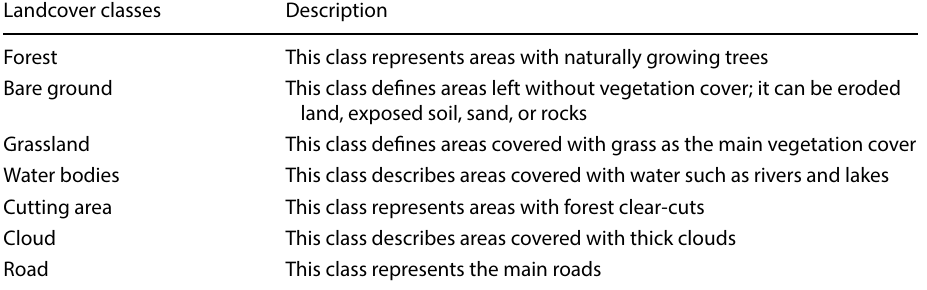
Table 1 Landcover classes in GNP and their